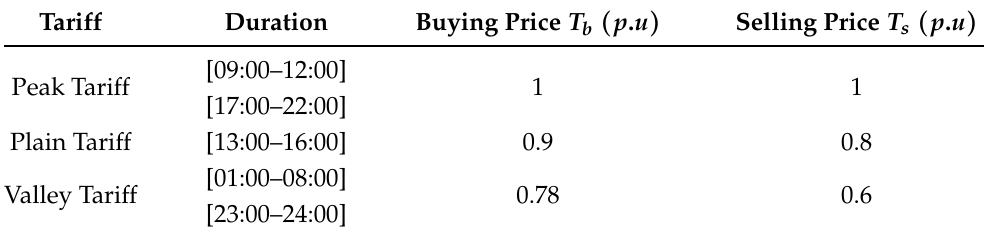
Table 3. Peak valley